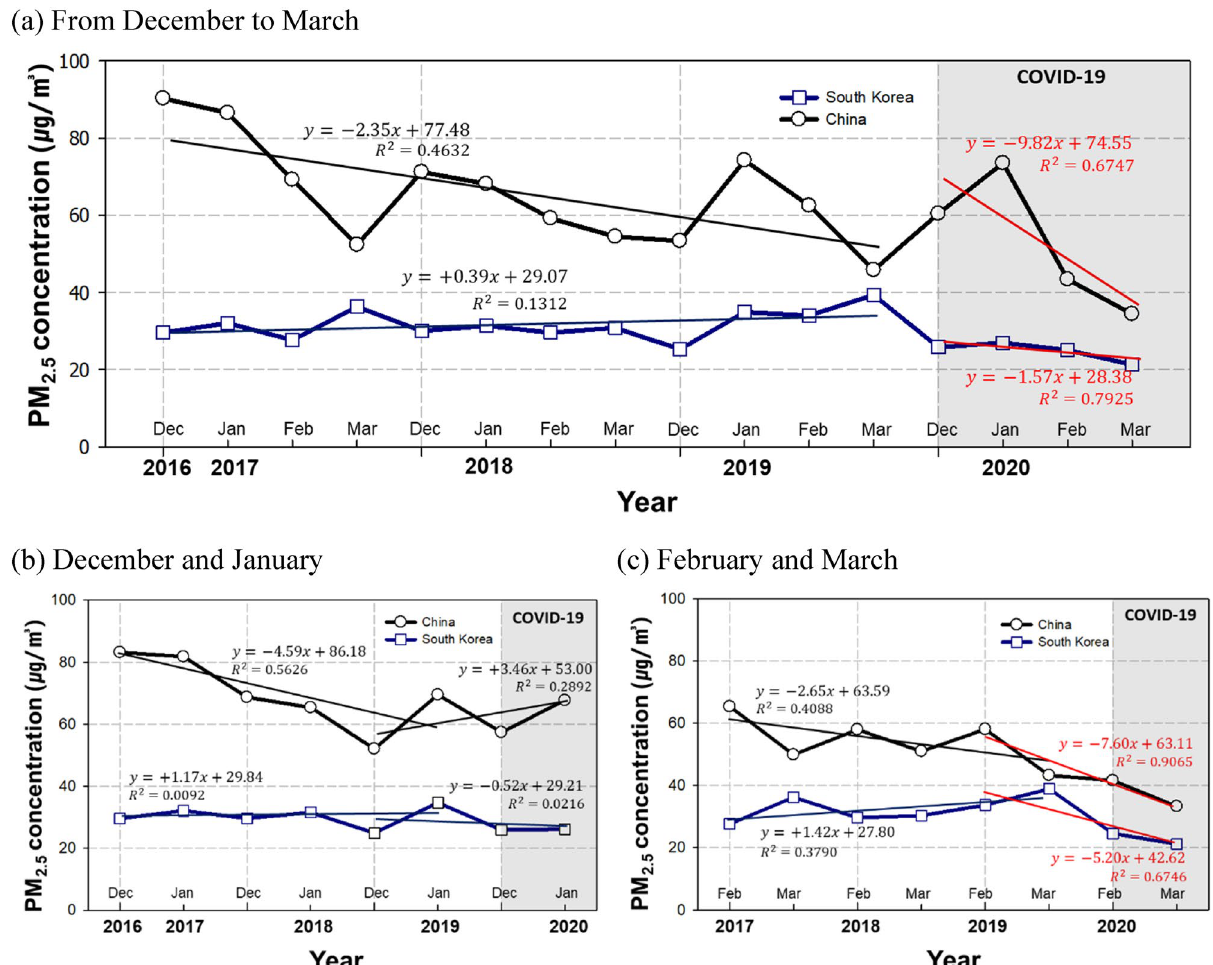
Figure 1. Monthly average change trends of PM 2.5 concentration observed in China and South Korea in 2016 to 2020. ( a ) From December to March ( b ) December and January, and ( c ) February and March. The blue and black lines represent the observed PM 2.5 concentrations in South Korea and China,